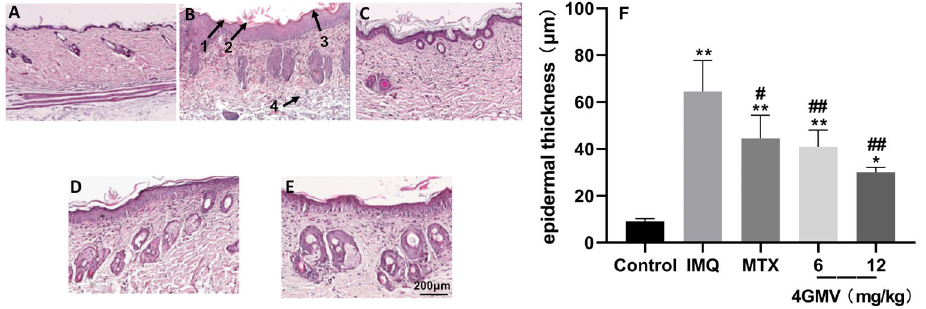
Figure 3. Histological evaluation of the back skin of imiquimod (IMQ)-induced psoriasis-like mice (staining with HE; magni fi cation 200 (cid:1) , scale bar 200 m m). A , Control group; B , Model group: arrows 1 – 4 indicate epidermal hyperplasia, hyperkeratosis, parakeratosis, and in fl ammatory cell in fi ltration, respectively; C , methotrexate (MTX) group (1 mg/kg); D , 4GMV low group (6 mg/kg); E , 4GMV high group (12 mg/kg). F , Epidermal thickness of skin lesions in mice (n=6). Data are reported as means ± SD. *P o 0.05 and **P o 0.01 compared with the control group; # P o 0.05 and ## P o 0.01 compared with the IMQ group (ANOVA followed by